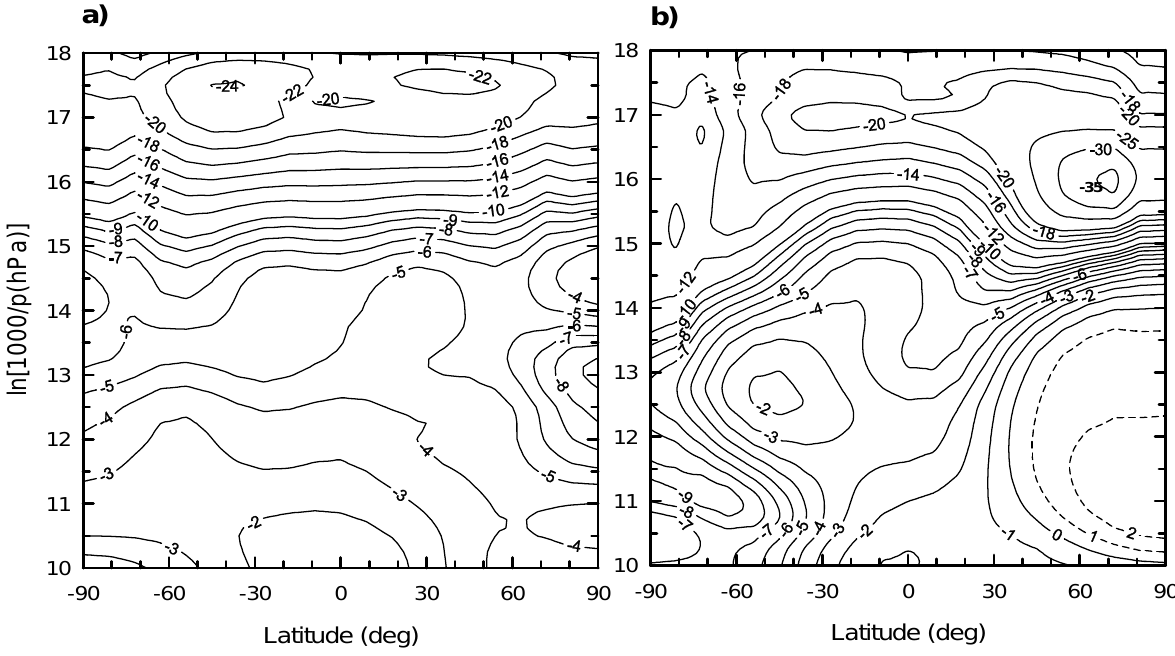
Fig. 9. Latitude-height distributions of heat influx in the CO 2 15- µ m band in K/day in the UMLT region for 16 March ( a ) and 1 July ( b ) , based on vertical profiles of temperature from the MSISE-90 model (Hedin, 1991). The dashed isolines correspond to atmospheric